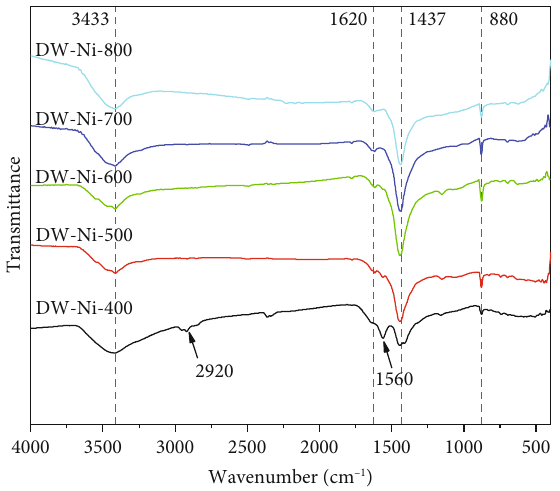
Figure 2: FTIR spectra of the catalysts prepared at di ff erent calcination temperatures.